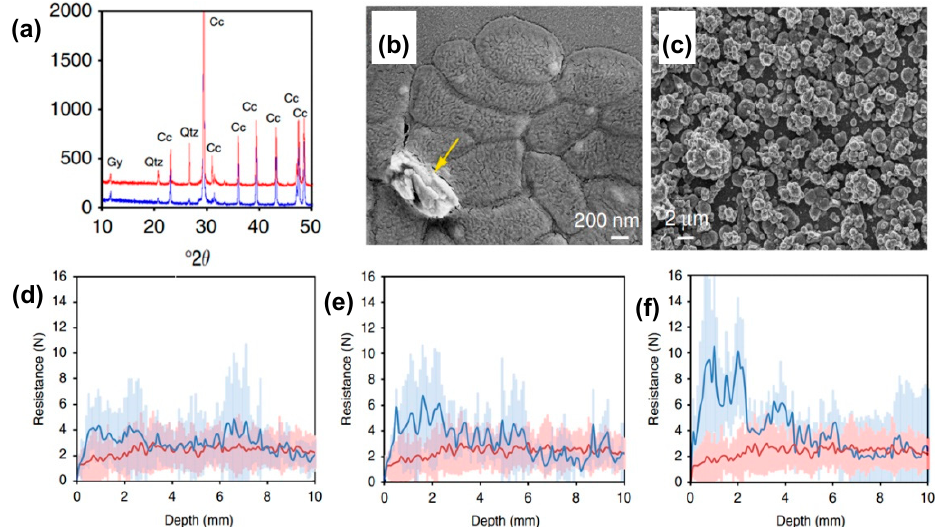
Figure 13. ( a ) XRD pattern before (blue) and after (red) MICP treatment. SEM images of ( b ) newly formed CaCO 3 ; ( c ) calcite substrate covered by bacterial calcite. Drilling resistance depth profile: ( d ) M. xanthus treatment (blue-line); ( e ) M-3P treatment (blue-line); ( f ) self-inoculated treatment (blue line). Untreated stones (red line) are presented for comparison. Shaded areas represent s.d. ( ± 1 σ ). Adapted with permission from